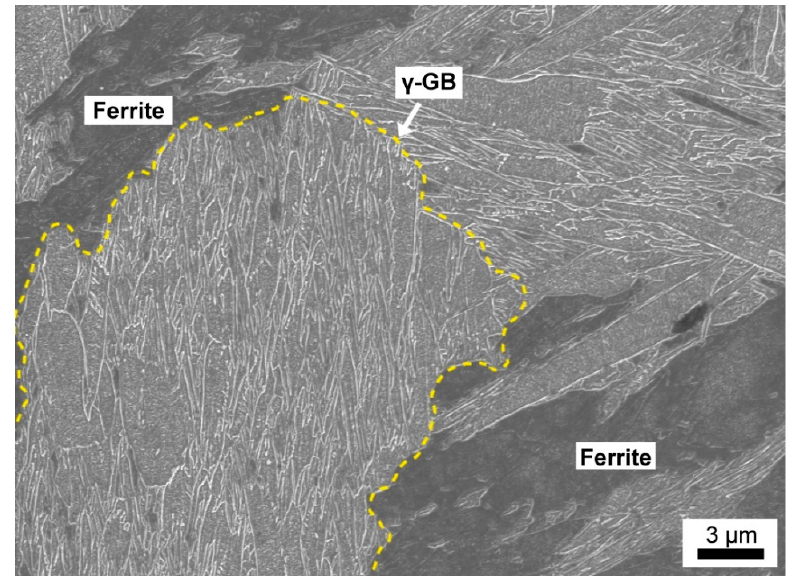
Figure 14. The microstructure in the PMZ under SEM.